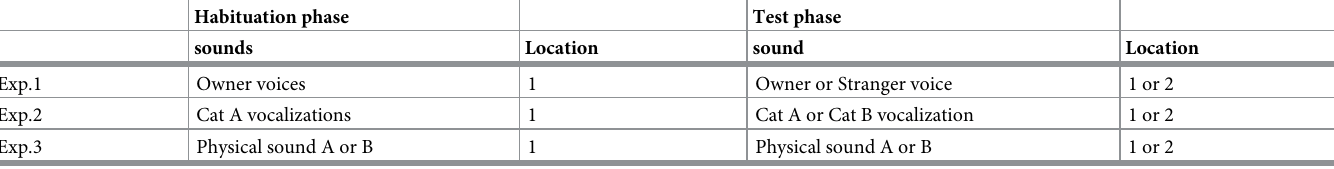
Table 1. Explanation of conditions in Exp.1 to